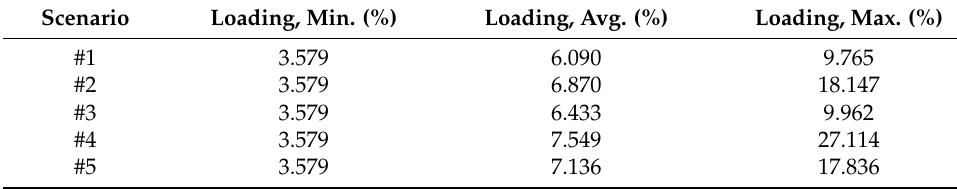
Table 3. Transformer loading.